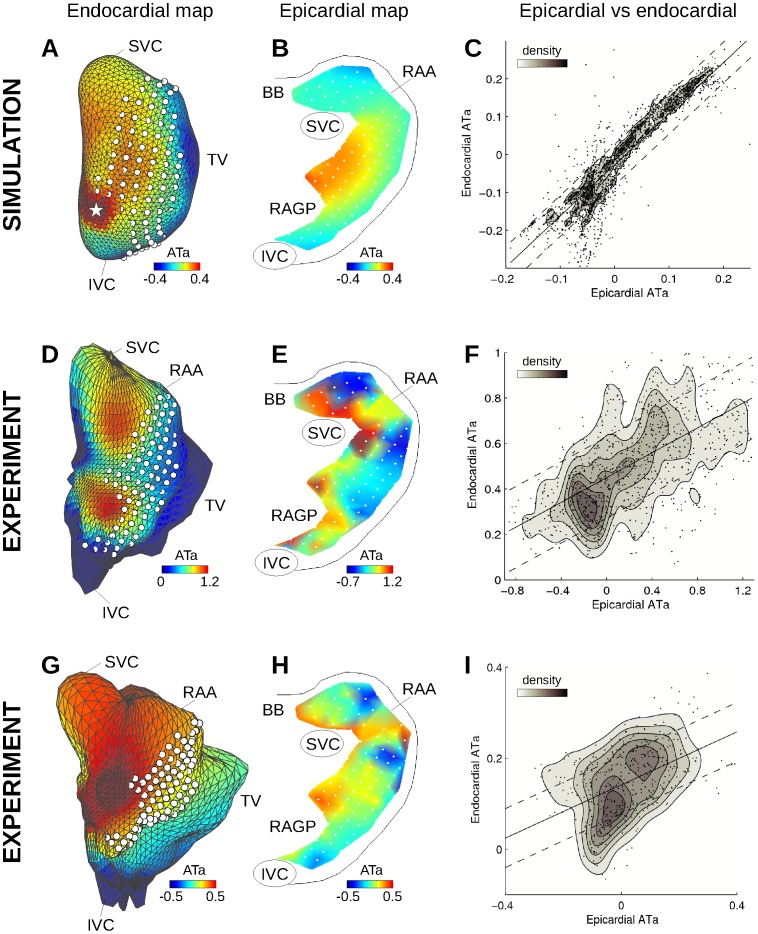
Endo- and epicardial ATa maps in the computer model (A–C) and in the experiments (D–I).(A) Color-coded simulated endocardial ATa map in the presence of repolarization heterogeneity with a radius of 3 mm around the white star. White dots represent epicardial electrode positions. (B) Simulated epicardial ATa map for the same beat. (C) Epi- vs endocardial simulated ATa for all simulations with different repolarization heterogeneity distributions, along with the linear regression curve and 50% confidence interval. Data point density estimated by kernel-based method is displayed as contour lines. (D) and (G) Examples of experimental endocardial ATa maps in two different dogs. (E) and (H) Experimental epicardial ATa map for the same beat. (F) and (I) Epi- vs endocardial ATa for all beats combined in each of the two dogs. SVC: superior vena cava; IVC: inferior vena cava; RAA: right atrium appendage; BB: Bachmann’s bundle; RAGP: right atrium ganglionated plexus.